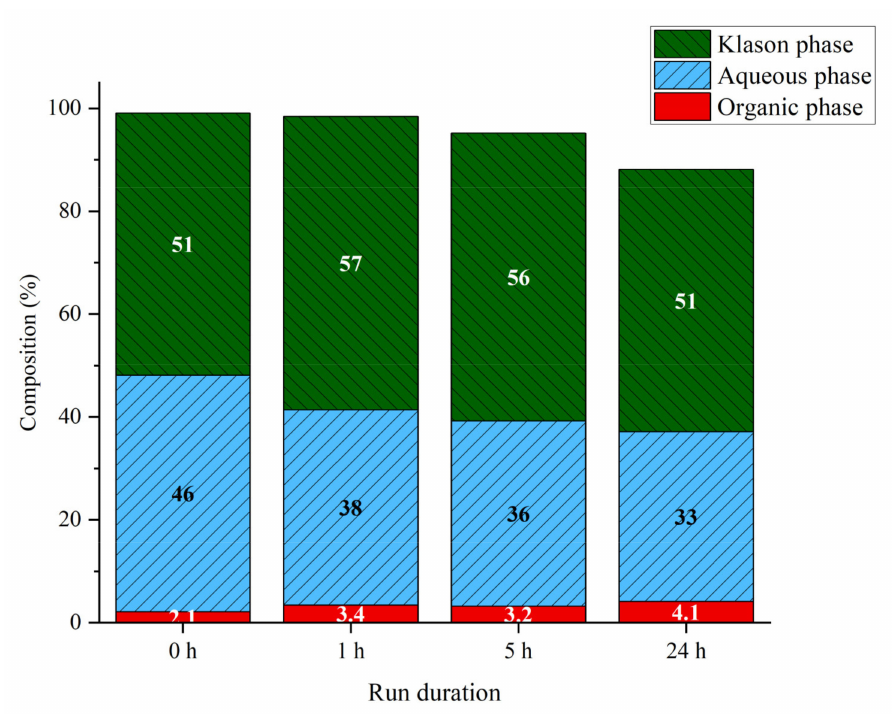
Figure 1. Phase compositions of lignin aqueous solutions at different run durations. Reaction conditions: Kraft lignin 10 g · L − 1 , 225 ◦ C, 40 bar